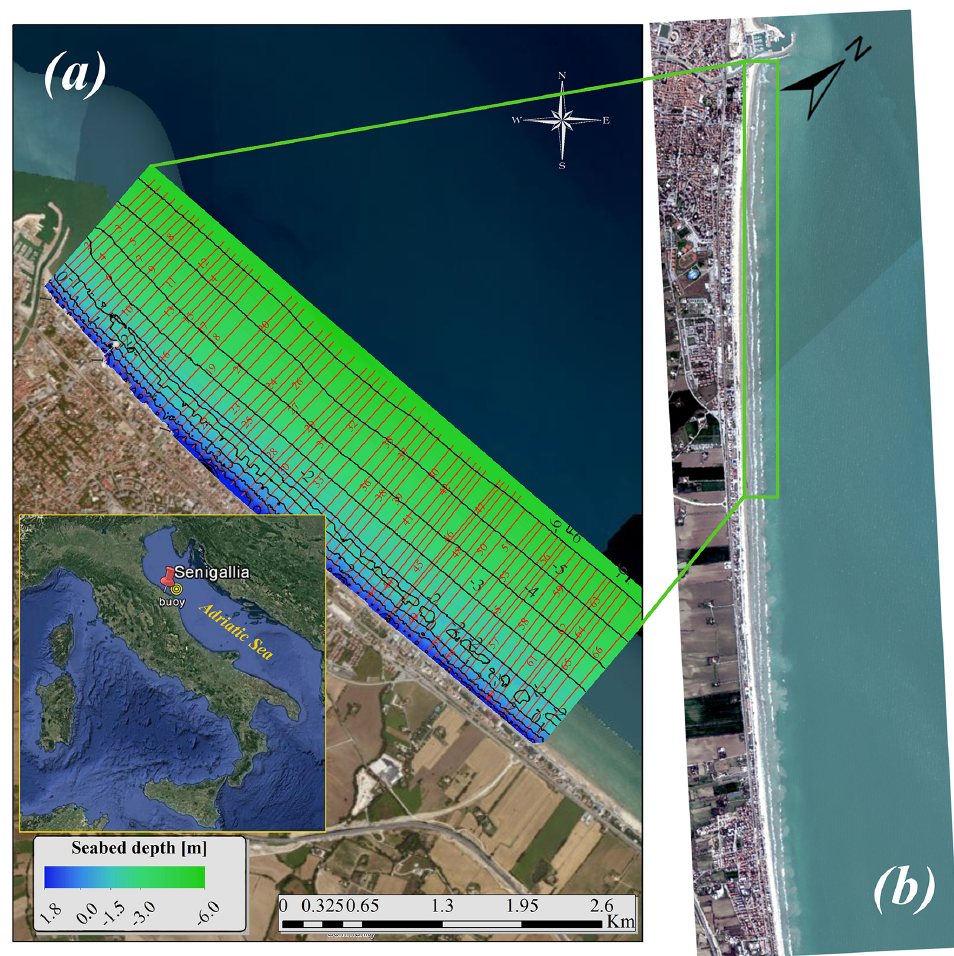
Figure 1. Natural beach of Senigallia: (a) bathymetry with isobaths and position of cross-shore profiles referring to June 2006 (the white spot between profiles 10 and 11 is the Rotonda) and (b) satellite view of ∼ 10km beach south of the harbor/Misa river